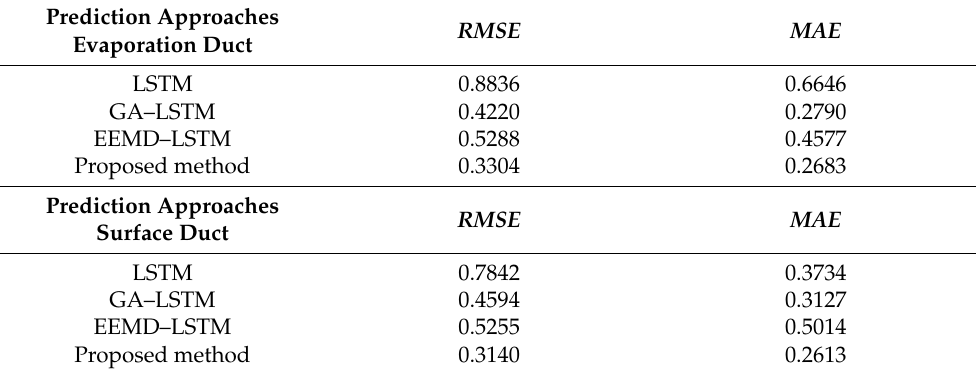
Table 11. Error estimation result based on the LSTM and hybrid LSTM methods.